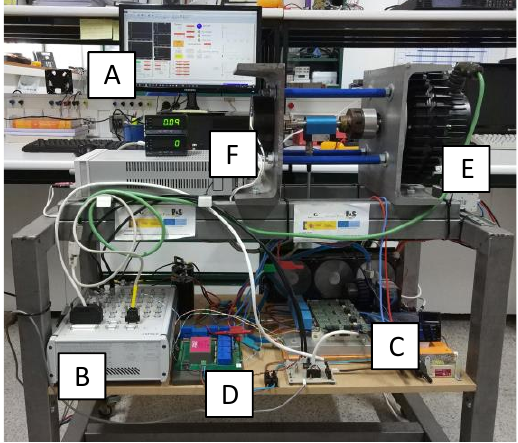
Figure 9. Experimental setup. ( A ) Host machine. ( B ) Target platform. ( C ) IGBT